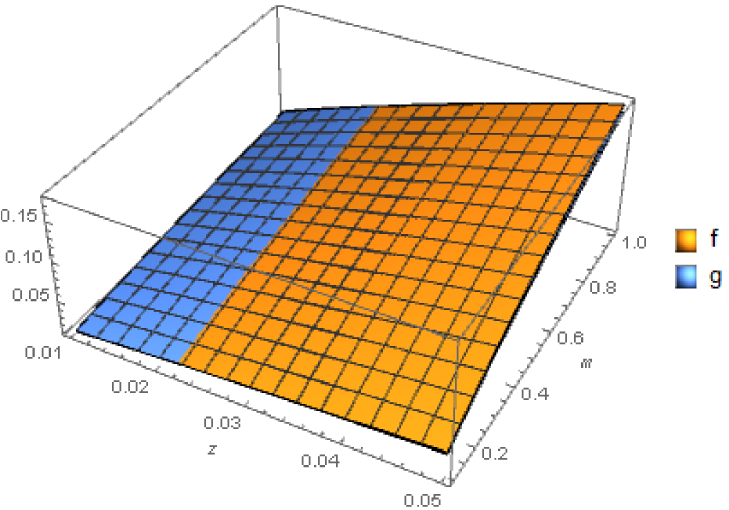
Fig 1. Growth rates f and g plotted against individual cell mass and substrate concentration. The parameter values selected were such that there is an intersection curve creating two regions where a different population has an